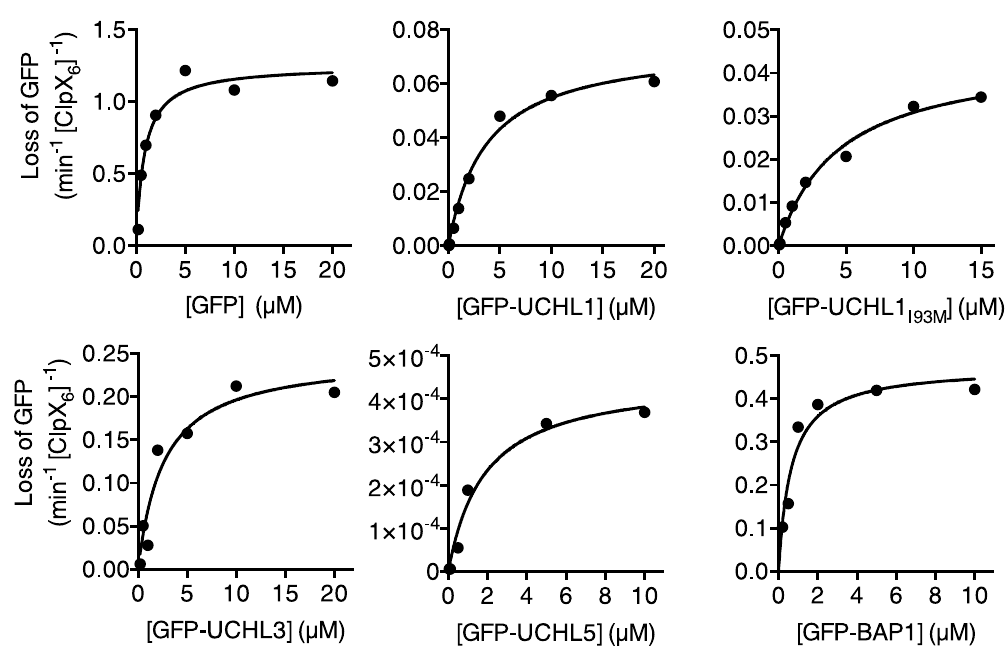
Figure 2. Michaelis-Menten analyses of GFP-CHs. Representative results of triplicates were shown for individual substrates. The initial rates of ClpXP-mediated proteolysis at various GFP-UCHs concentrations (as indicated below the X-axis of each panel) were extracted from fitting the changes in GFP fluorescence within the first 60